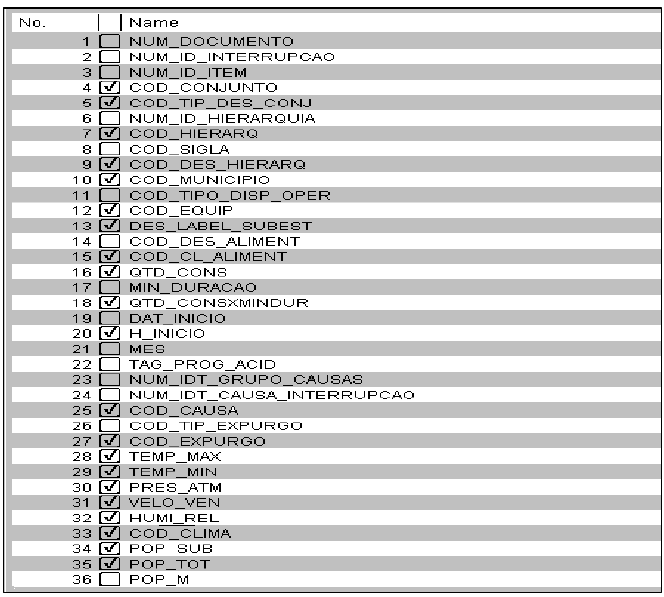
Figure 2: WEKA EXPLORER – Configuration.